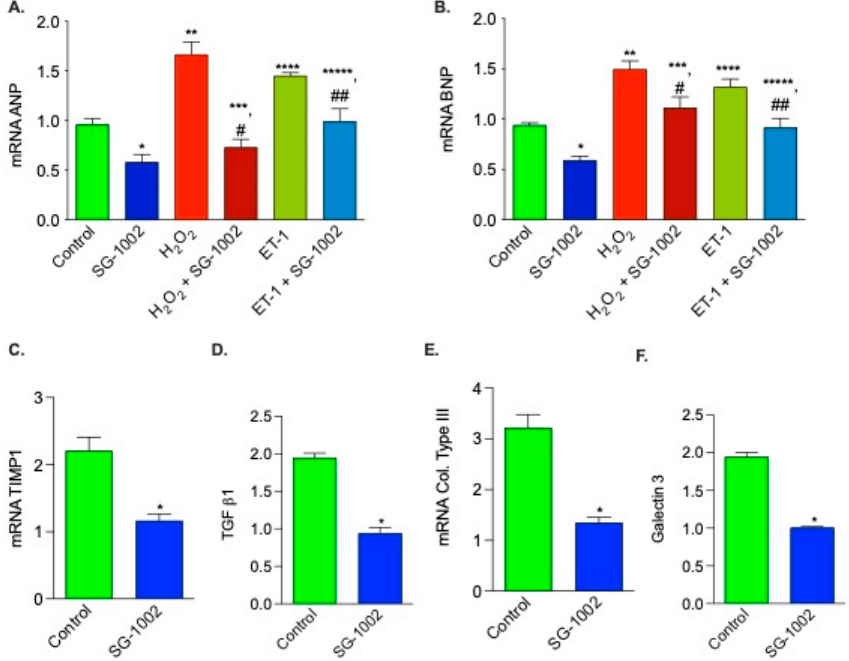
Figure 6. Effects of SG -1002 on the expression of HF markers in HL-1 cells. cDNA was prepared from RNA obtained from treated HL-1 cells as described in Materials and Methods followed by analysis of mRNA of ANP ( A ), BNP ( B ), TIMP1 ( C ), TGF b1 ( D ), collagen (col) type III ( E ), and galectin 3 ( F ) using the TaqMan PCR assay system. *, **, and ****, p < 0.05 vs. control; #, p < 0.05 SG-1002 vs. H 2 O 2 + SG-1002; ***, p < 0.05 H 2 O 2 vs. SG-1002 + H 2 O 2 ; ##, p < 0.05 ET-1 vs. SG-1002 + ET1; *****, p < 0.05, SG-1002 vs. ET1 + SG-1002 (Anova) ( A , B ) (n = 4); t test ( C – F ) (n =